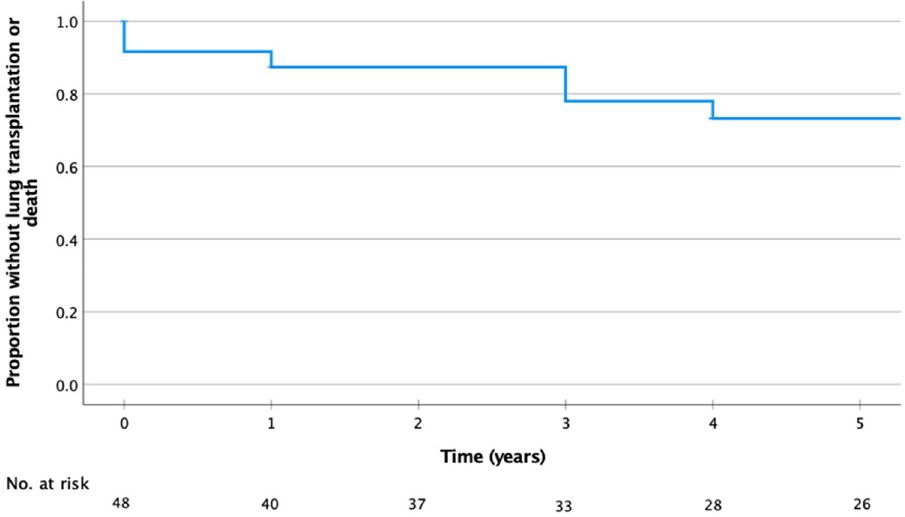
Figure 1. Kaplan–Meier survival curve free from death/transplantation from the time of sirolimus initiation. Mean time of sirolimus treatment was 5.6 ± 3.5 years.